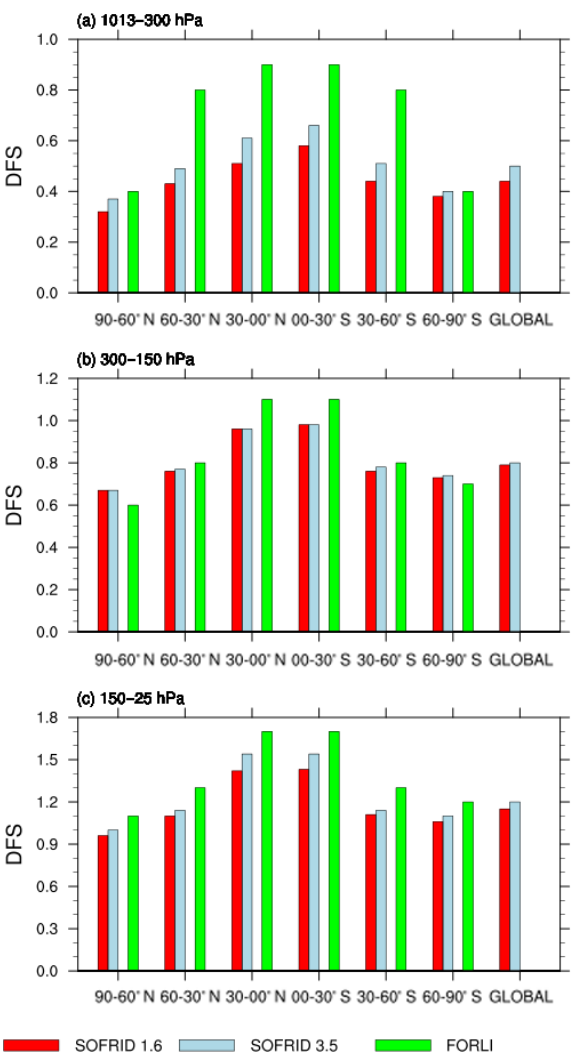
Figure 14. b indicates slopes of the linear regression (positive values), and (–) R 2 indicates coefficients of determination (nega- tive values) between IASI retrievals and sonde data. Red indicates SOFRID-O3 v1.6, light blue indicates SOFRID-O3 v3.5, and green indicates FORLI-O3 (from Boynard et al.,